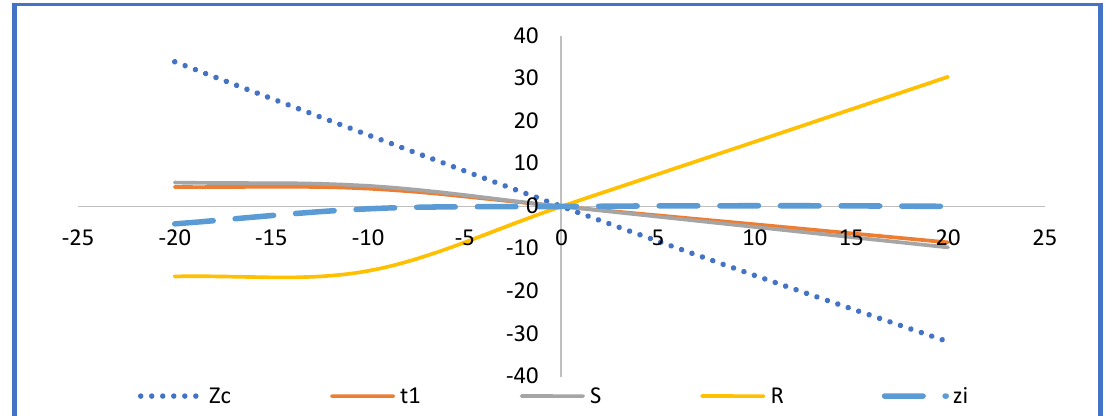
(cid:2) (cid:3) C pL , C pU ’ on Z C , t 1 , S , R , and ξ